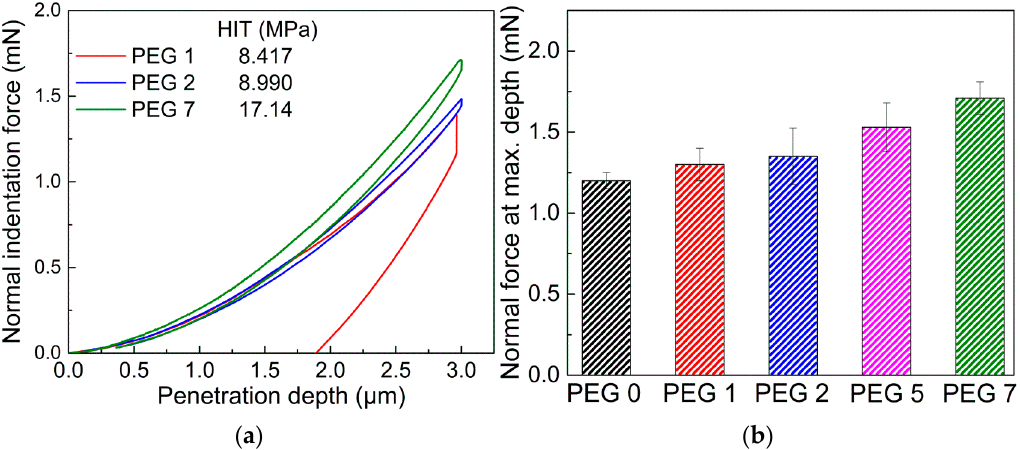
Figure 6. ( a ) Normal indentation force vs. penetration depth profiles and ( b ) maximum normal indentation forces at a 3 µ m depth for the cured hydrogel films with varying G-SiNP contents via the nano-indentation test (NHT 3 ). The indentation hardness (HIT) values are shown in ( a ).